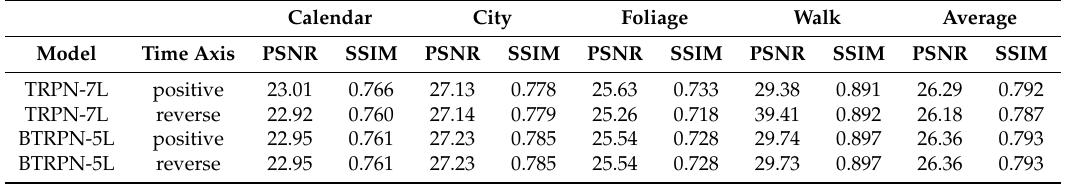
Table 5. Results of the bidirectional and non-bidirectional model for 4 × VSR on the VID4 dataset. Calendar City Foliage Walk